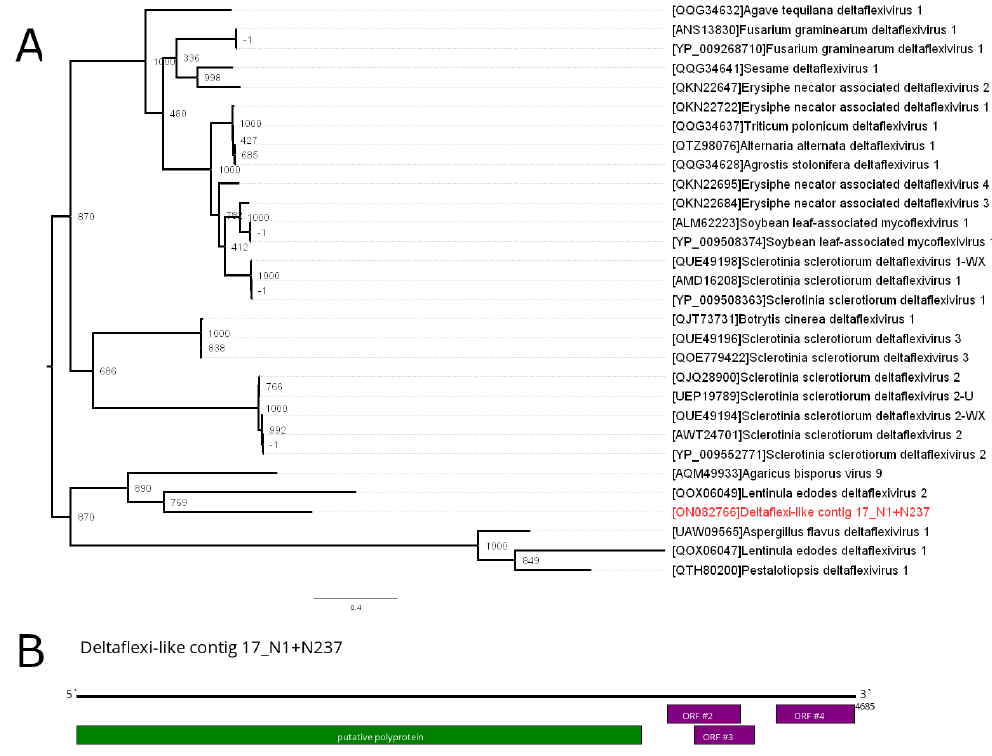
Figure 5. Phylogenetic relationships and genetic structure of the deltaflexi-like contig 17_N1 + N237. ( A ) Phylogenetic relationships of the sequences of contig-encoded polyprotein using amino acid sequence with 1000 bootstrap replicates. Bootstrap support values are shown for each node. Scale bar represents the number of amino acid substitutions per site. Deltaflexi-like contig 17N1 + N237 is marked red. ( B ) Scheme of the deltaflexi-like contig 17_N1 + N237.